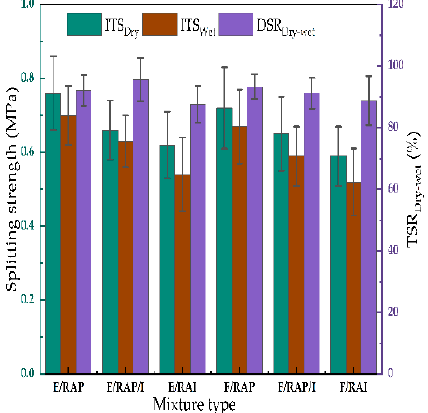
Figure 5. ITS test results of different CRMs.